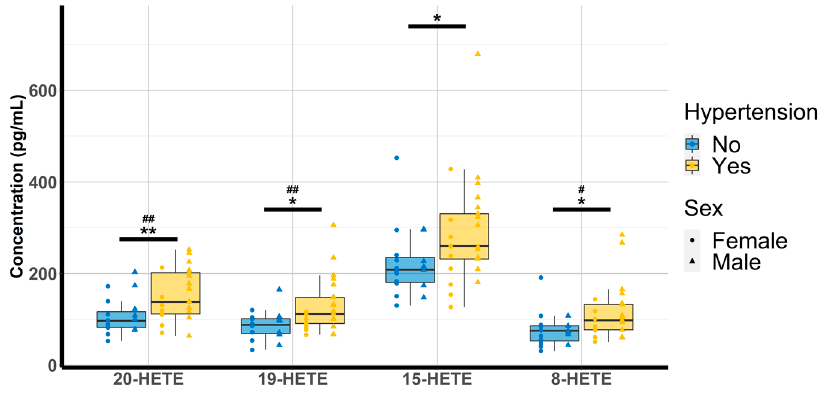
Figure 2. Evaluation of HTN and gender effect on 20-HETE, 19-HETE, 15-HETE, and 8-HETE (n = 44). HETE: hydroxyeicosatetraenoic acid. * p < 0.05, ** p < 0.01 (hypertension); # p < 0.05 ## p < 0.01 (sex).